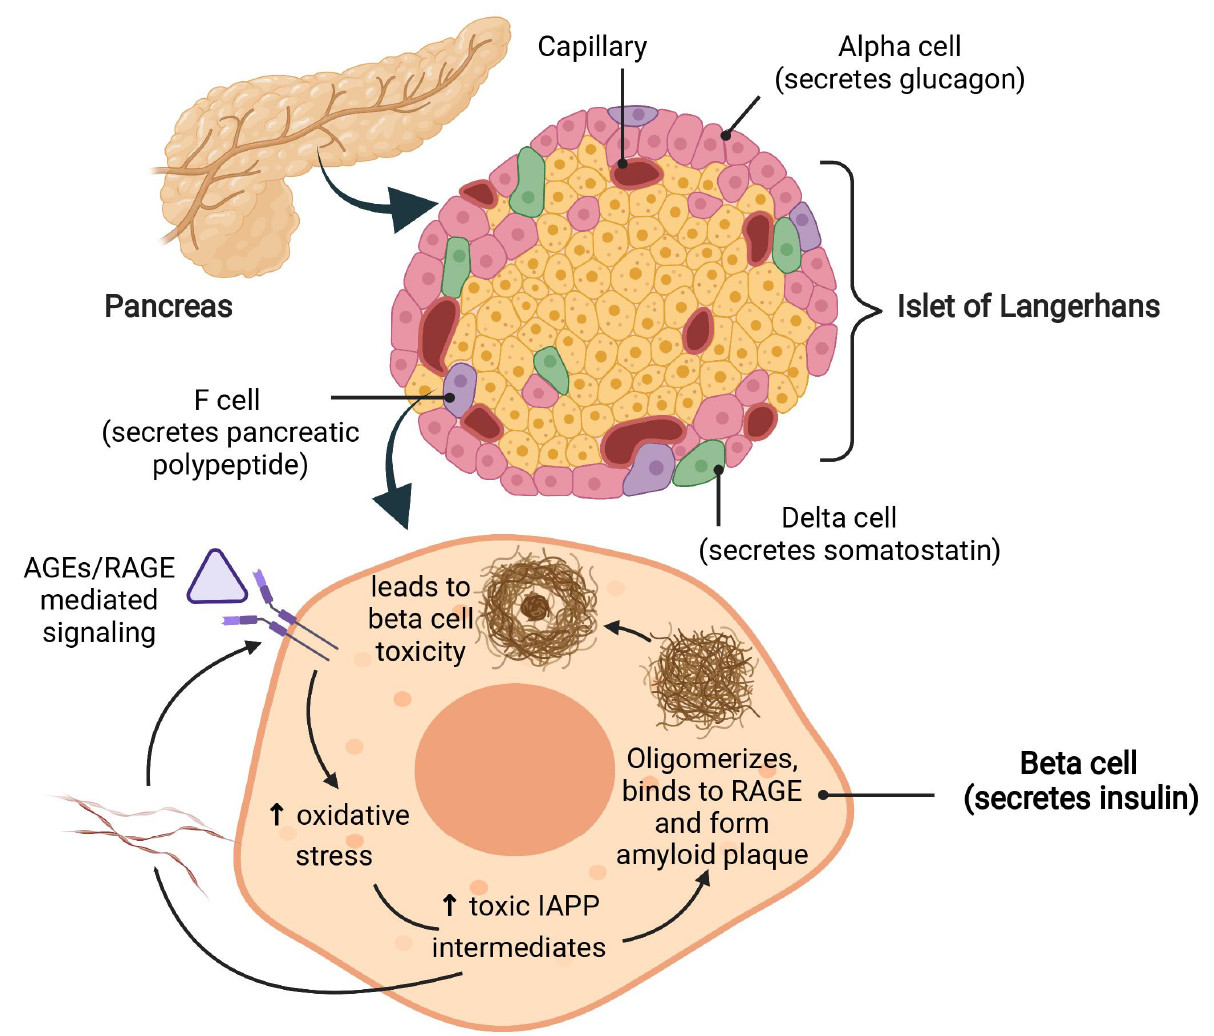
Figure 2. AGEs/RAGE-induced pancreatic beta cell toxicity. The AGEs/RAGE mediated signaling causes enhanced oxidative stress and increased inflammation in pancreatic beta cells. The generation of damaging reactive oxygen species (ROS) during oxidative stress affects the amyloidogenicity of islet amyloid polypeptide (IAPP) and leads to the formation and aggregation of toxic IAPP species. RAGE binds with these toxic IAPP intermediates and leads to the formation of amyloid plaque resulting in pancreatic beta cell toxicity.